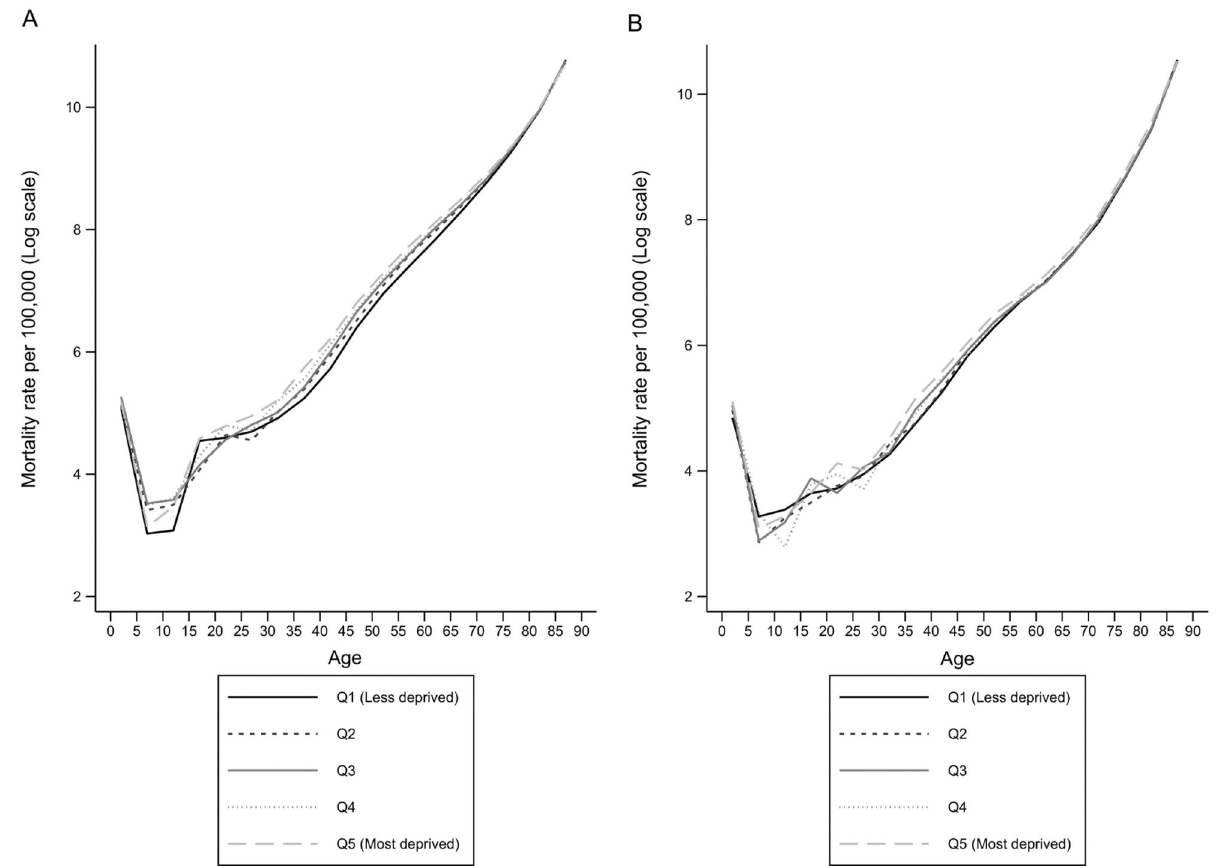
Figure 1. Observed mortality rates per 100,000 people by deprivation quintile, age group and sex ( A : men, B : women) in Spain,